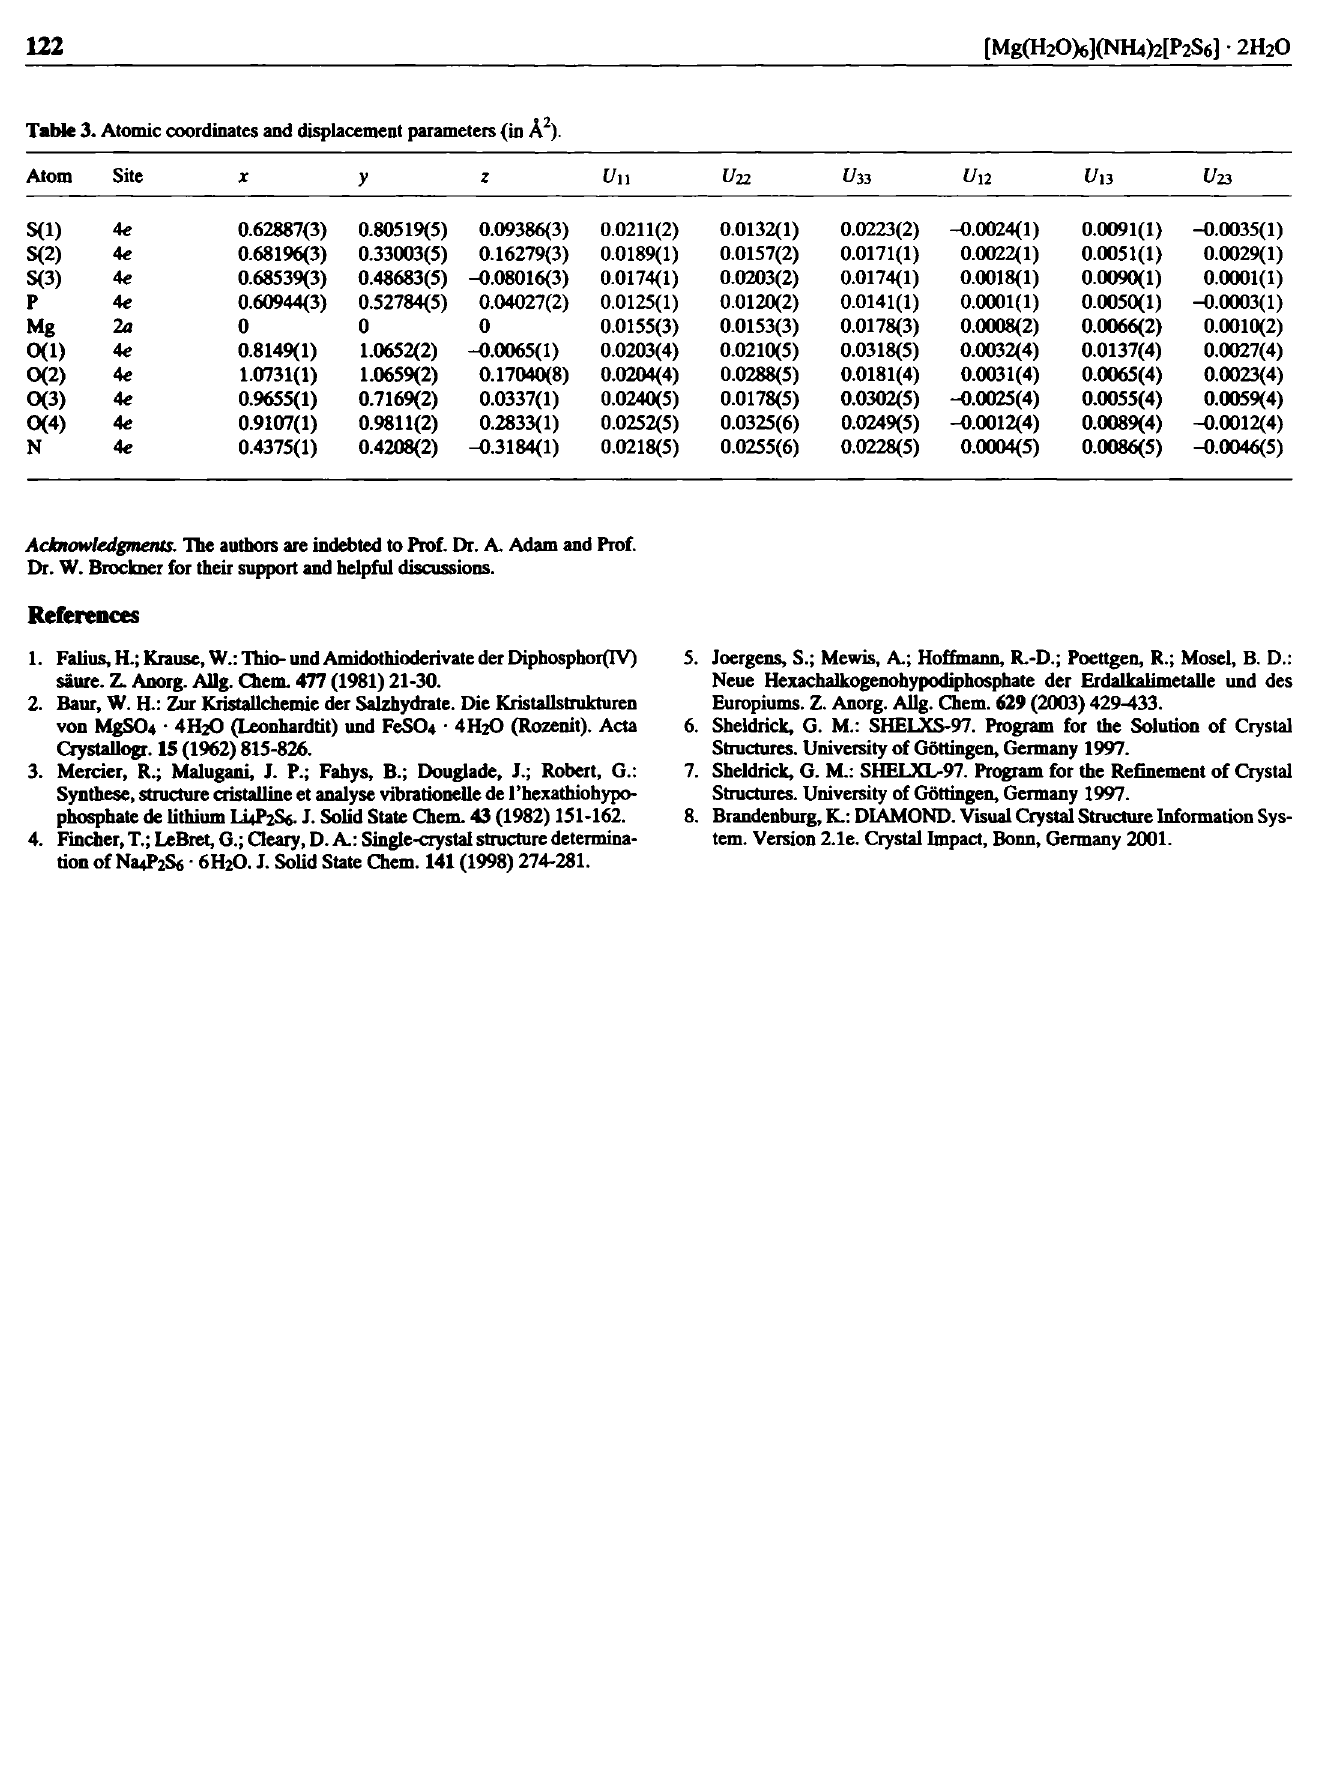
Table 3. Atomic coordinates and displacement parameters (in A 2